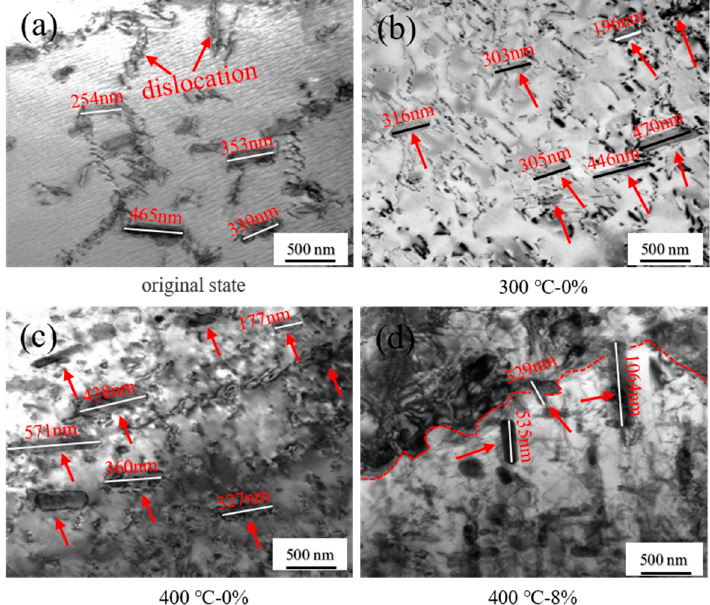
Figure 5. Transmission electron microscope (TEM) images of 2A12-T4 aluminum alloy under different thermal strain coupling parameters. ( a ) Room temperature untreated, e.g., base material; ( b ) Without strain under peak temperature of 300 ℃ ; ( c ) Without strain under peak temperature of 400 ℃ ; ( d ) 8% pre-strain was given at peak temperature of 400 ℃ .